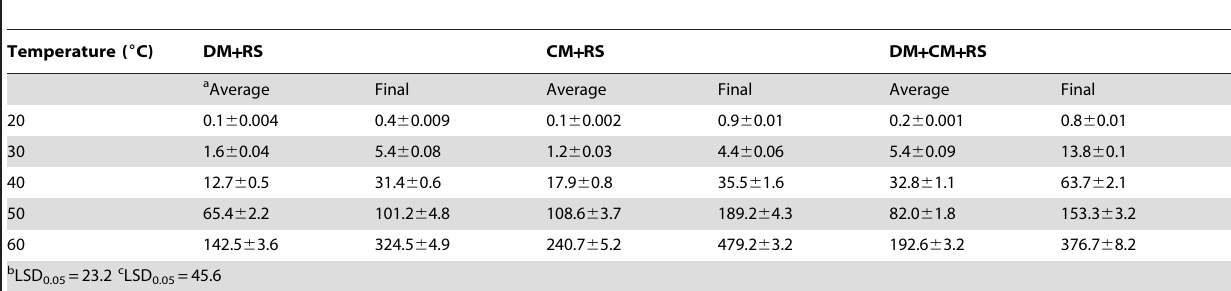
Table 4. Effects of temperature on free ammonia content in in anaerobic co-digestion with a C/N ratio of 25.